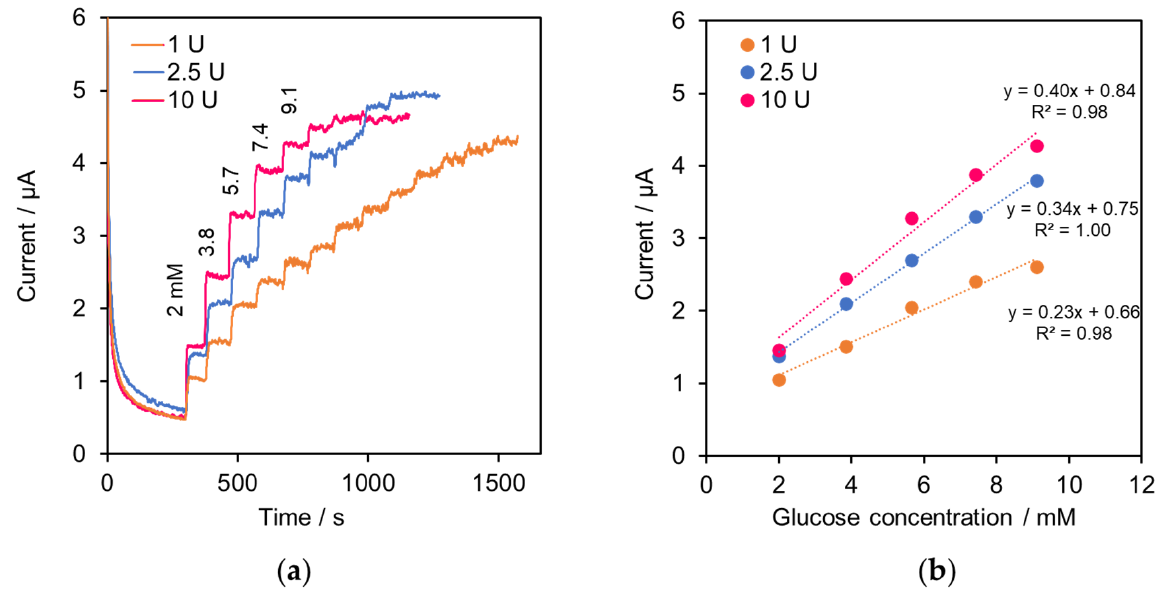
Figure 2. Optimization of GOD–SWCNTs–AuNPs-modified SPE: ( a ) a series of chronoamperograms of GOD–SWCNTs–AuNPs-modified SPE with various amount of GOD (1, 2.5 and 10 U) at applied potential +0.8 V showing increasing current response as glucose was added in PBS bulk solution; ( b ) plots between current response and added glucose concentration for each SPEs.